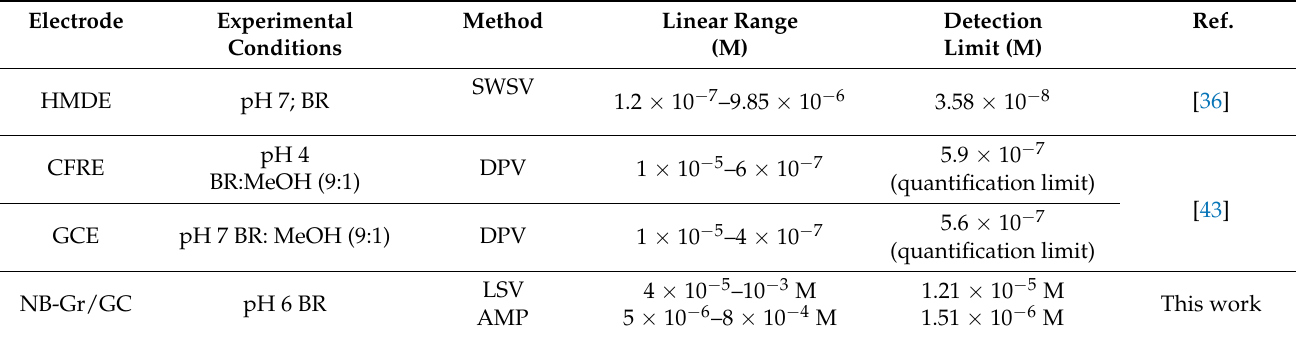
Table 1. The electrochemical performances of NB-Gr/GC electrode compared with those of other types of electrodes, found in the